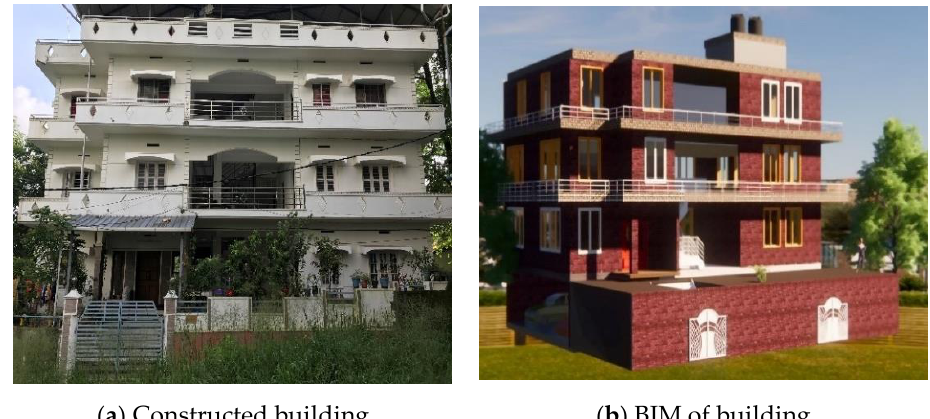
Figure 4. 3D View of residential building.